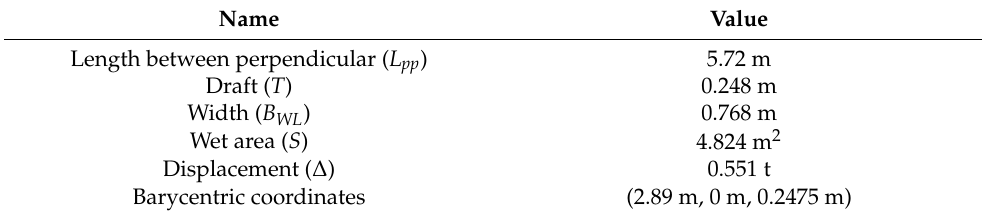
Figure 5. DTMB5415 ship hull form. Table 6. Main parameters of DTMB5415 ship model (scale ratio α = 22.832).